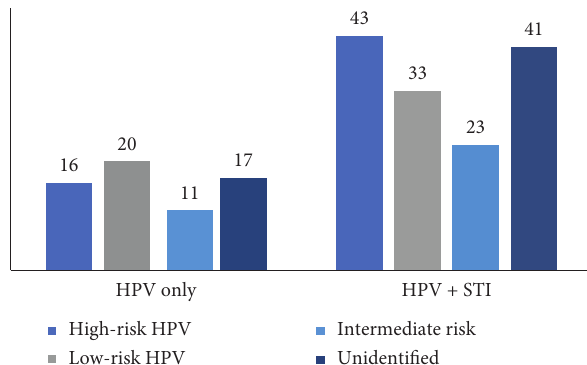
Figure 2: Distribution of HPV viral types according to the oncogenic potential in women with single HPV infection and women with HPV/ STIs ( C. trachomatis , N . gonorrhoeae , and T. vaginalis ). Table 2: Risk factors for HPV presence in women according to odds ratio and confidence interval (95% CI). Odds ratio CI (95%) p